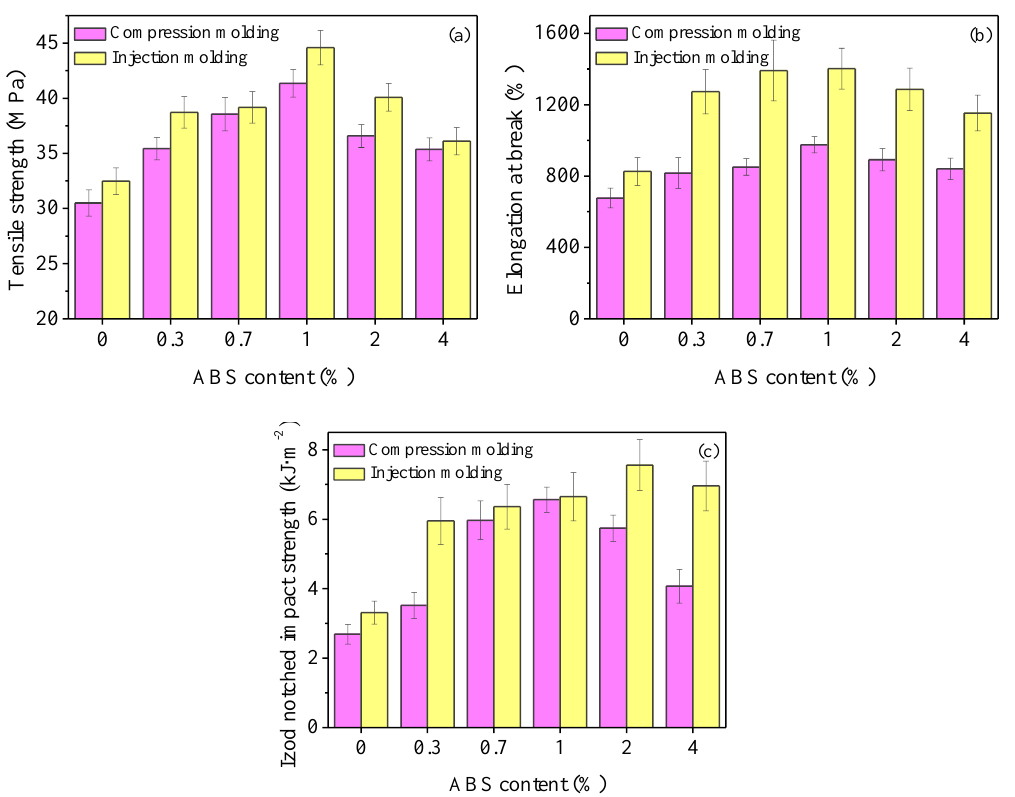
Figure 9. Effect of ABS content on ( a ) tensile strength, ( b ) elongation at break, and ( c ) impact strength of iPP/ABS blends.